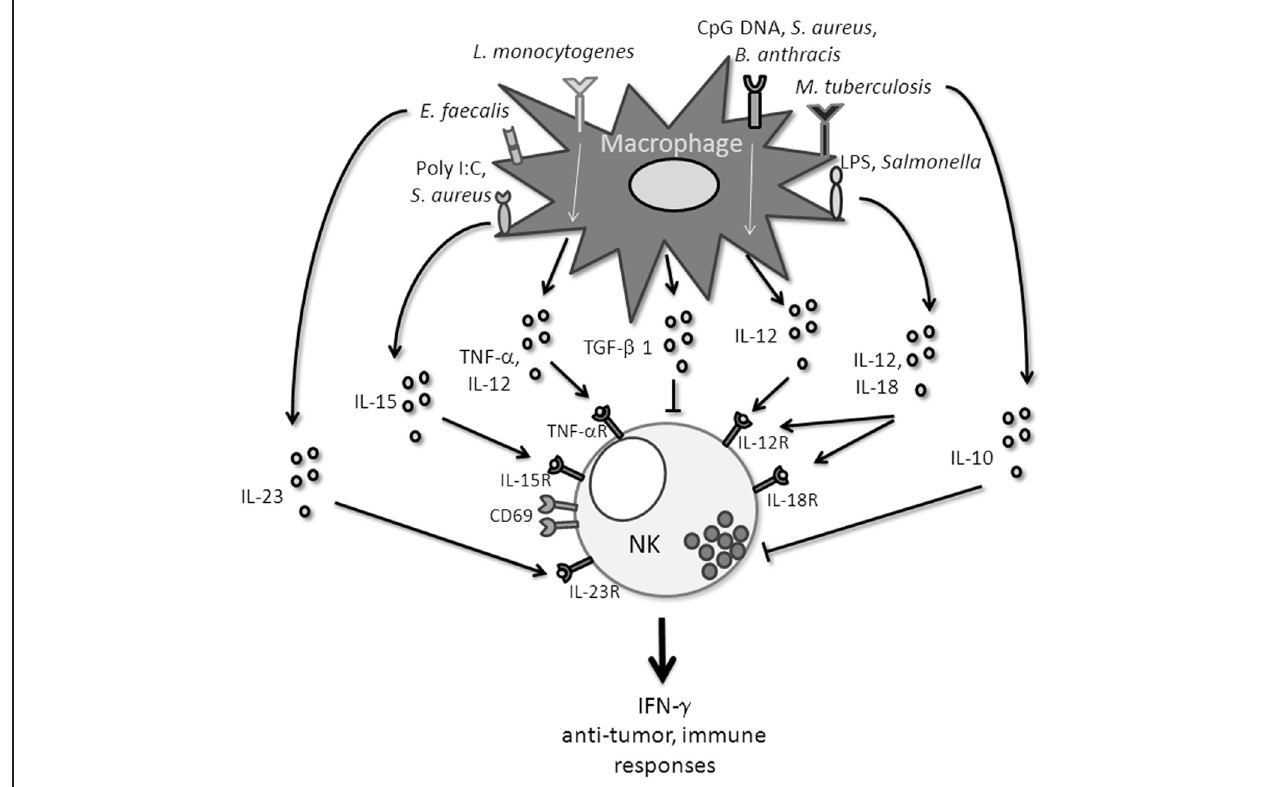
FIGURE 1 | Different macrophage-derivated signals that influence NK cell